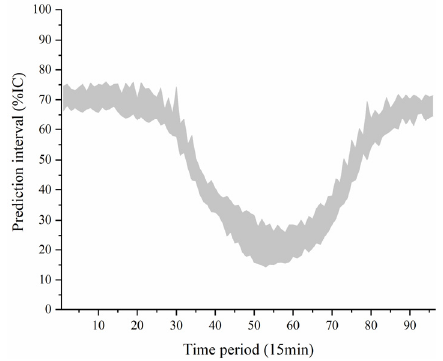
Figure A1. Prediction intervals of wind power stakeholder.